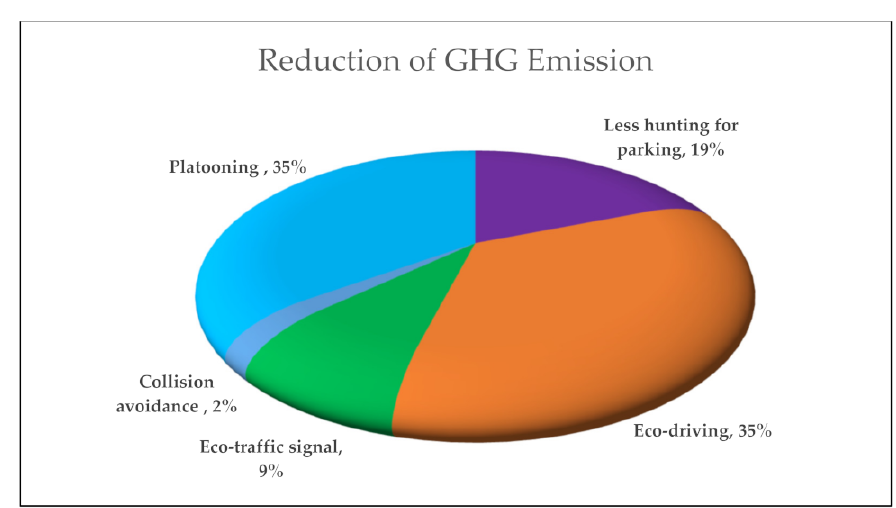
Figure 3. Average contribution of the causes on GHG emission